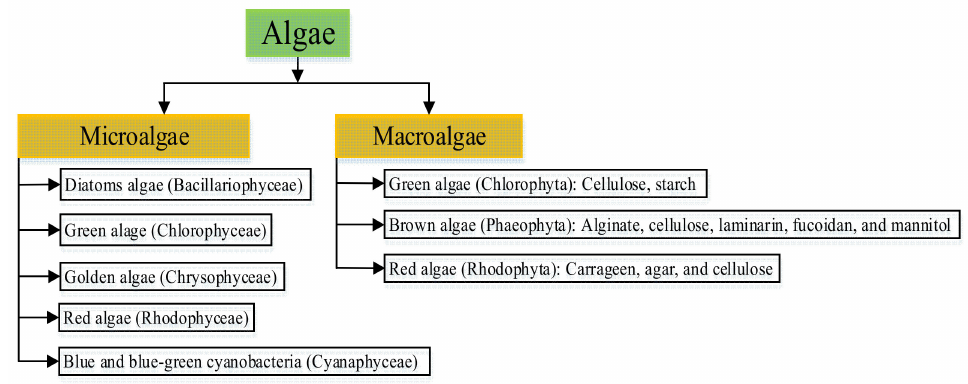
Figure 5. Classification of microalgae and macroalgae. Adapted from [33,72]. Developed by the